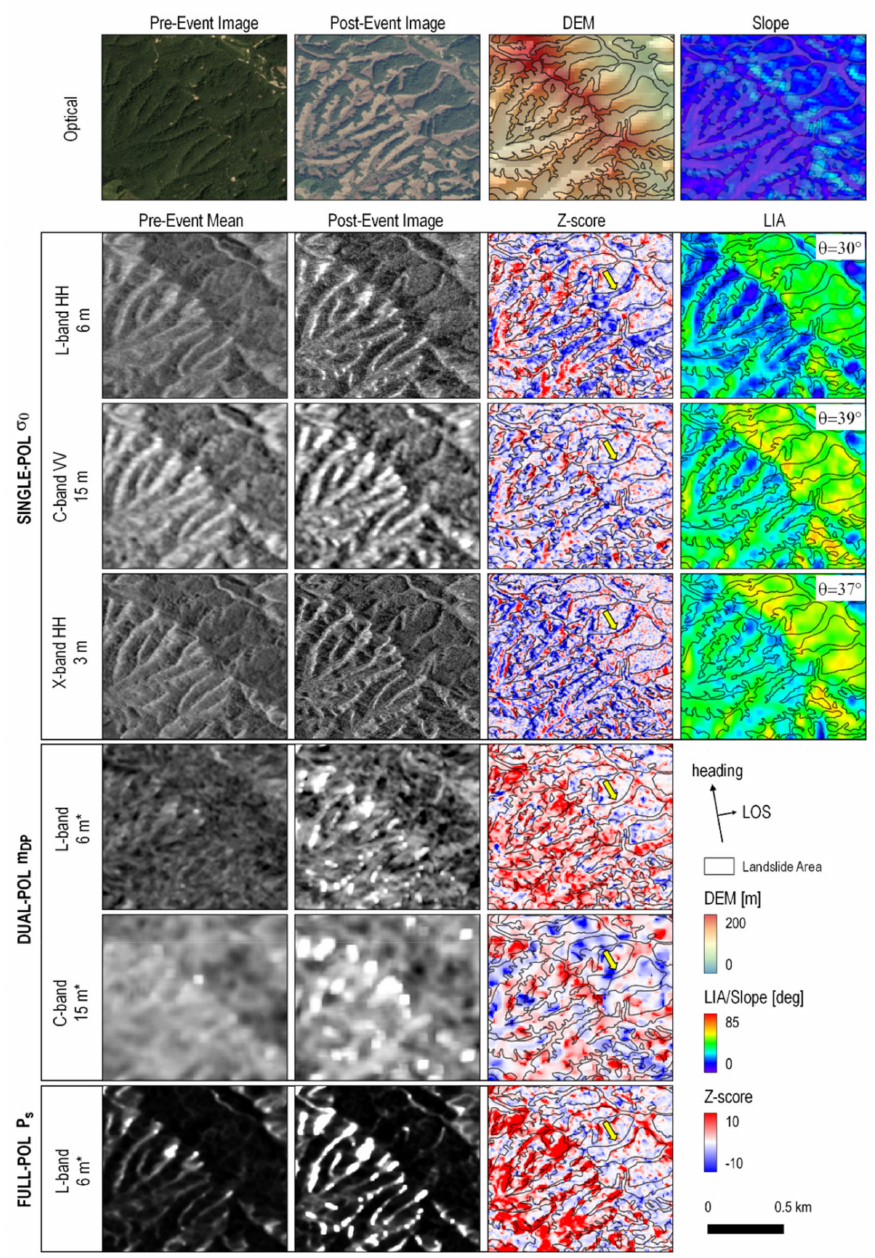
Figure 4. A qualitative comparison among different datatypes for Hokkaido Test Area 2 (see Table 1 for data sources). The value 3 m, 6 m and 15 m are the spatial resolutions, with the asterisk (*) indicating images processed by taking spatial ensemble averaging. DEM: digital elevation model. LIA: local incidence angle. The LIA maps for the multi-pol datatypes are the same as those in the single-pol. Θ : satellite look angle. Yellow arrows on Z-score maps indicate one particular landslide that is well captured by σ 0 but not by m DP and P s